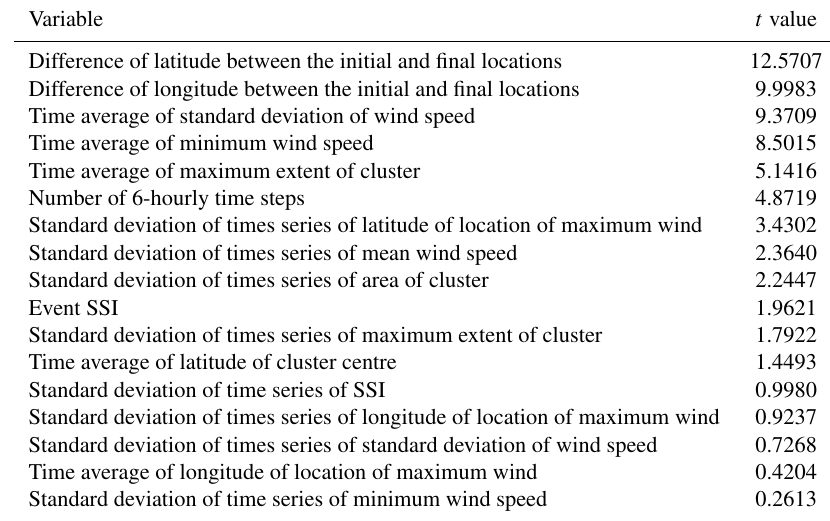
Table 3. List of explanatory variables and their associated t values which are used in the construction of the LRC.